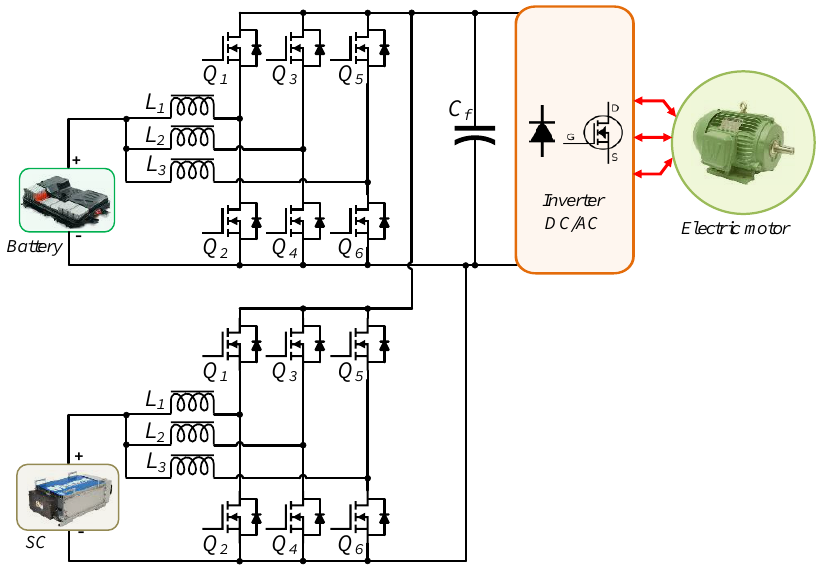
Figure 2. Non-isolated MPC using an interleaved bidirectional converter for each port in the Full Electric Bus powertrain.